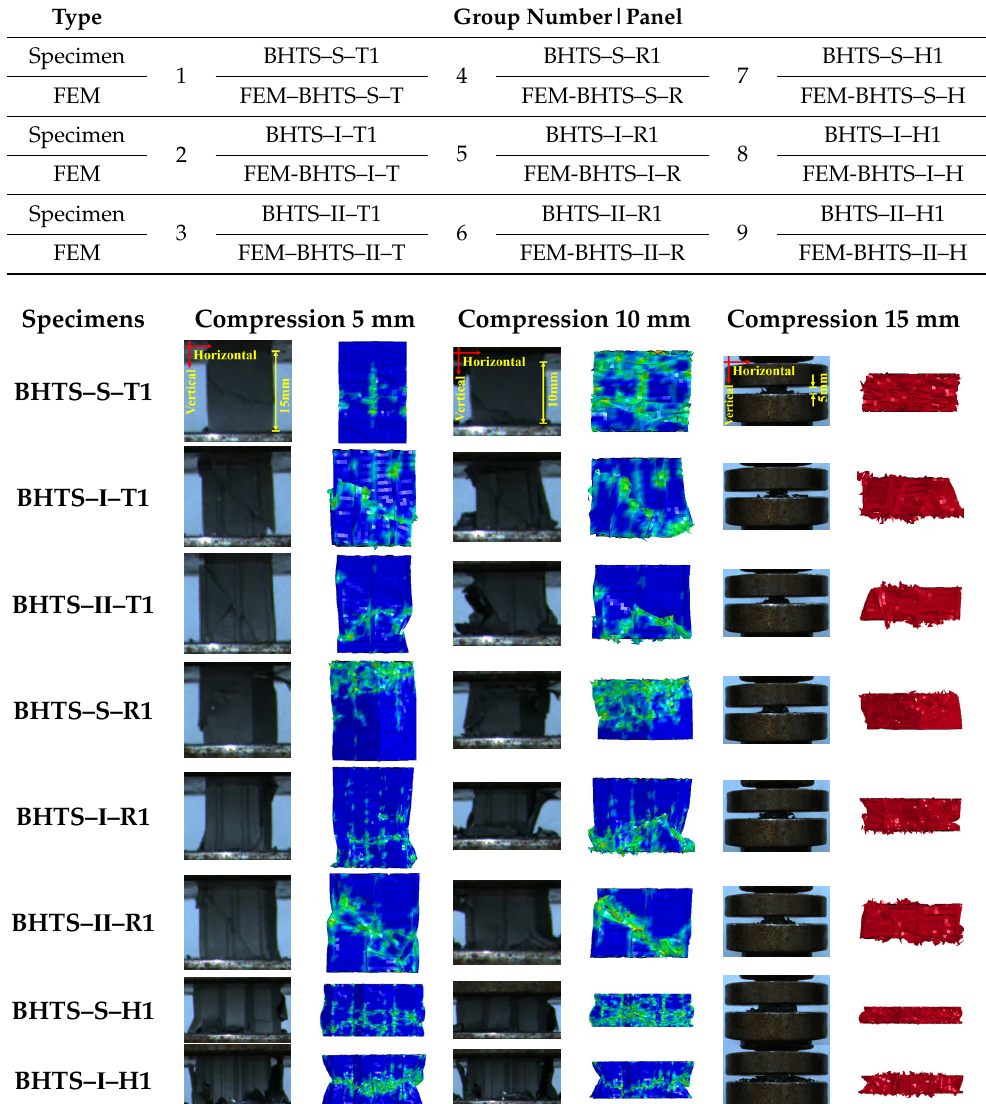
Table 3. BHTS test set number.